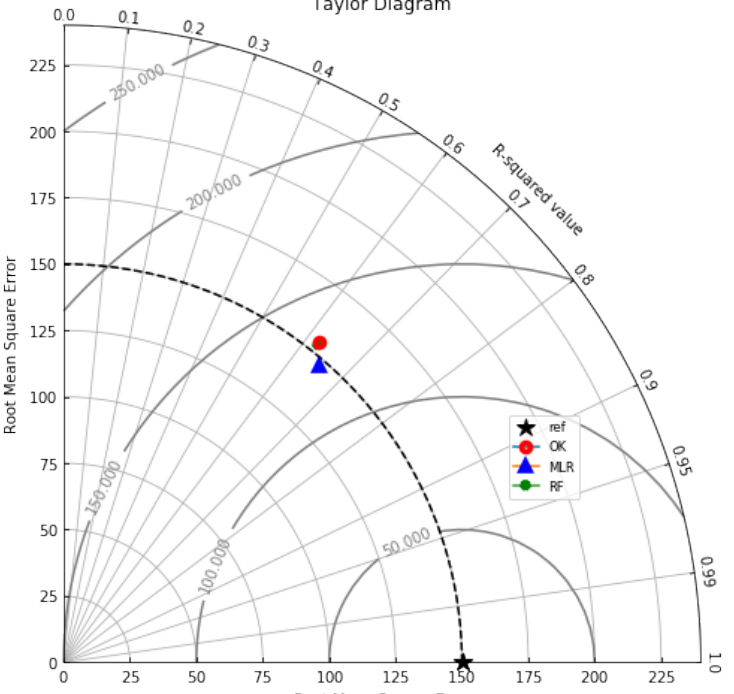
Figure 8. Taylor diagram summarising the R-squared and RMSE of the OK, MLR and RF models.